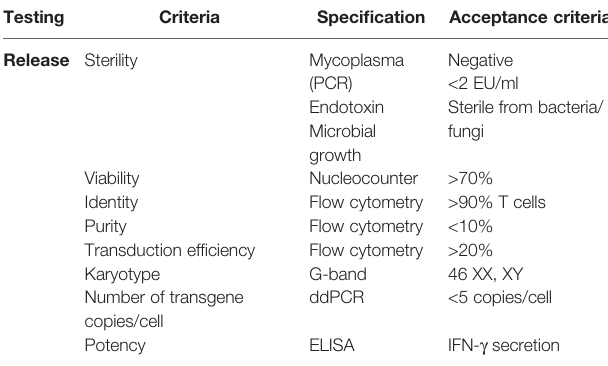
TABLE 2 | Quality control of TCR-T